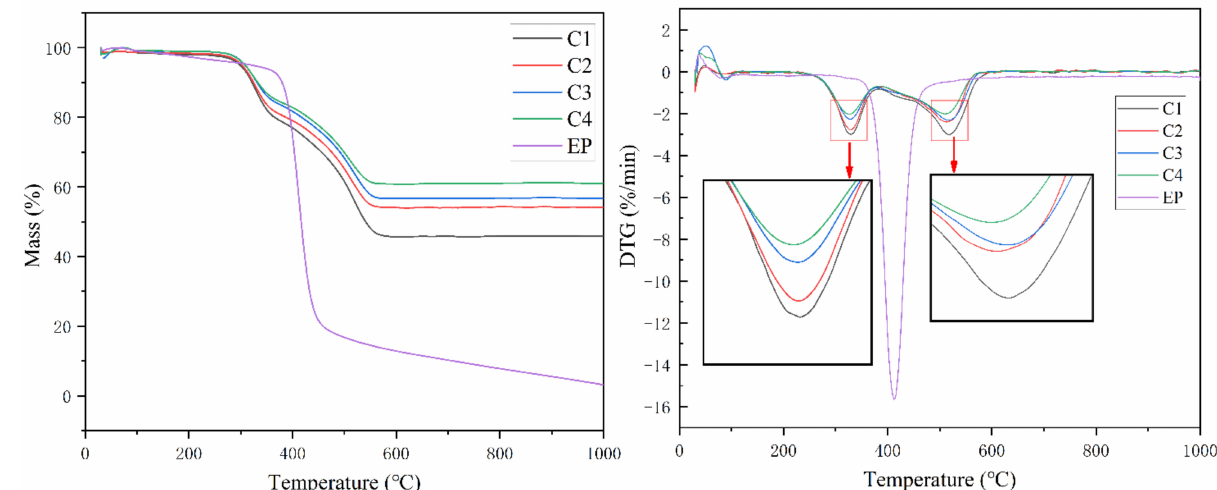
Figure 1. TG and DTG curves of samples C1, C2, C3, C4 and EP. The residual weights of the samples C1, C2, C3 and C4 at 1000 ◦ C are 45.81%, 54.17%, 1000 ◦ C is only 3.15%. The thermal decomposition parameter of C1–C4 and EP are listed in